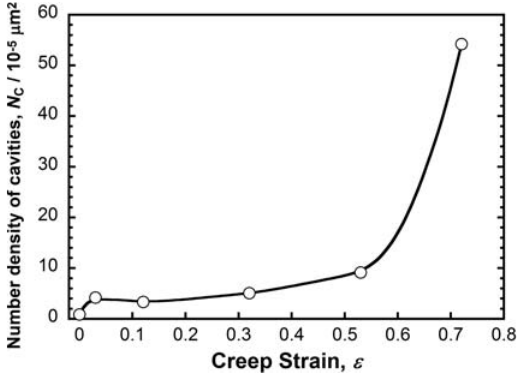
Figure 11: Changes in the number density of cavities as a function of the creep